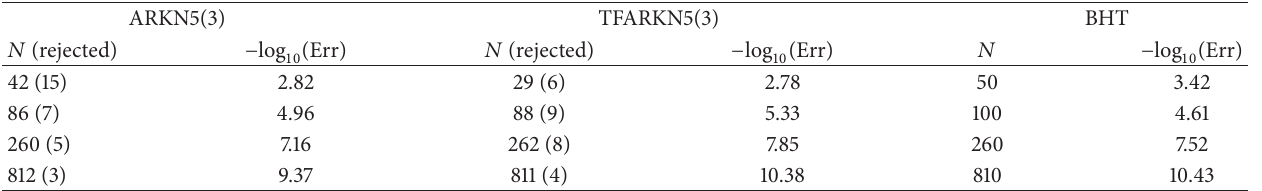
Table 3: A comparison of methods for Example 3.